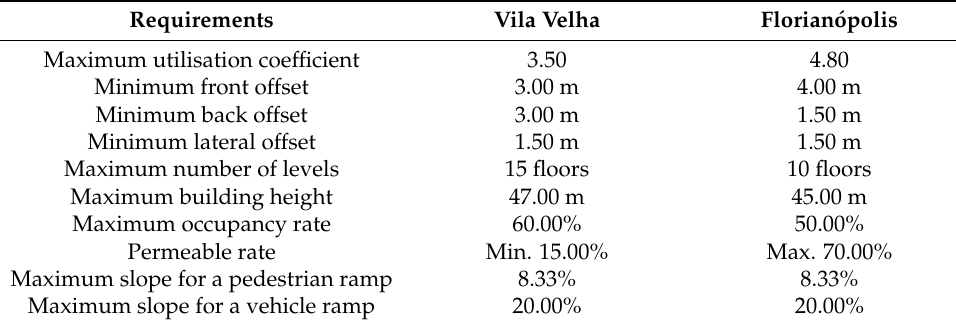
Table 1. Vila Velha and Florian ó polis master plan requirements.